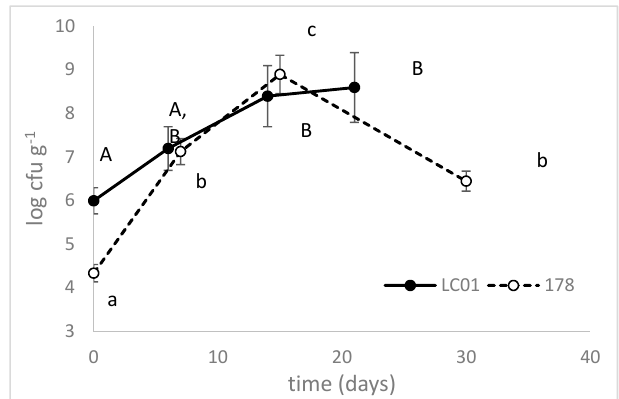
Figure 3. Micro-staphyoloccci counts during the ripening of traditional sausages inoculated with Lb. casei LC01 or Lb. plantarum 178. Mean ± standard deviation. The letters indicate statistically significant di ff erences throughout time (one-way ANOVA and Tukey’s test, p < 0.05): small letters, sausages inoculated with Lb. plantarum 178; capital letters,